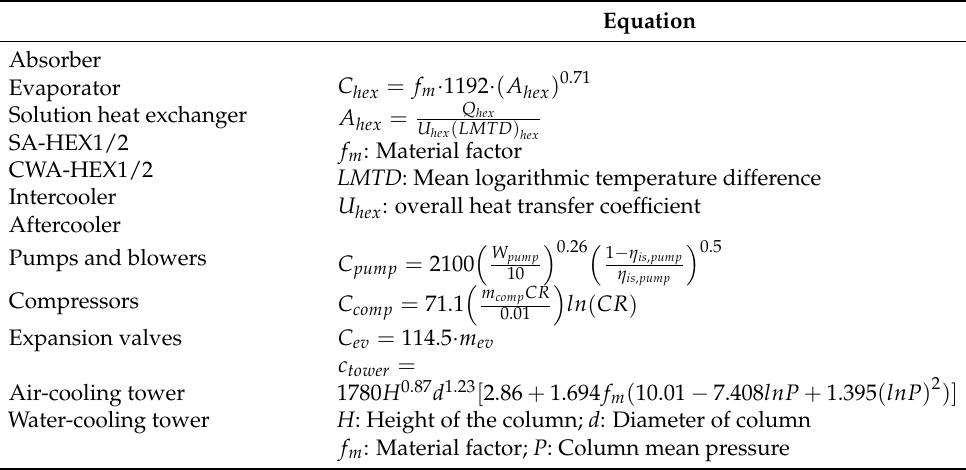
Table 3. Calculation of initial capital cost of the main system equipment